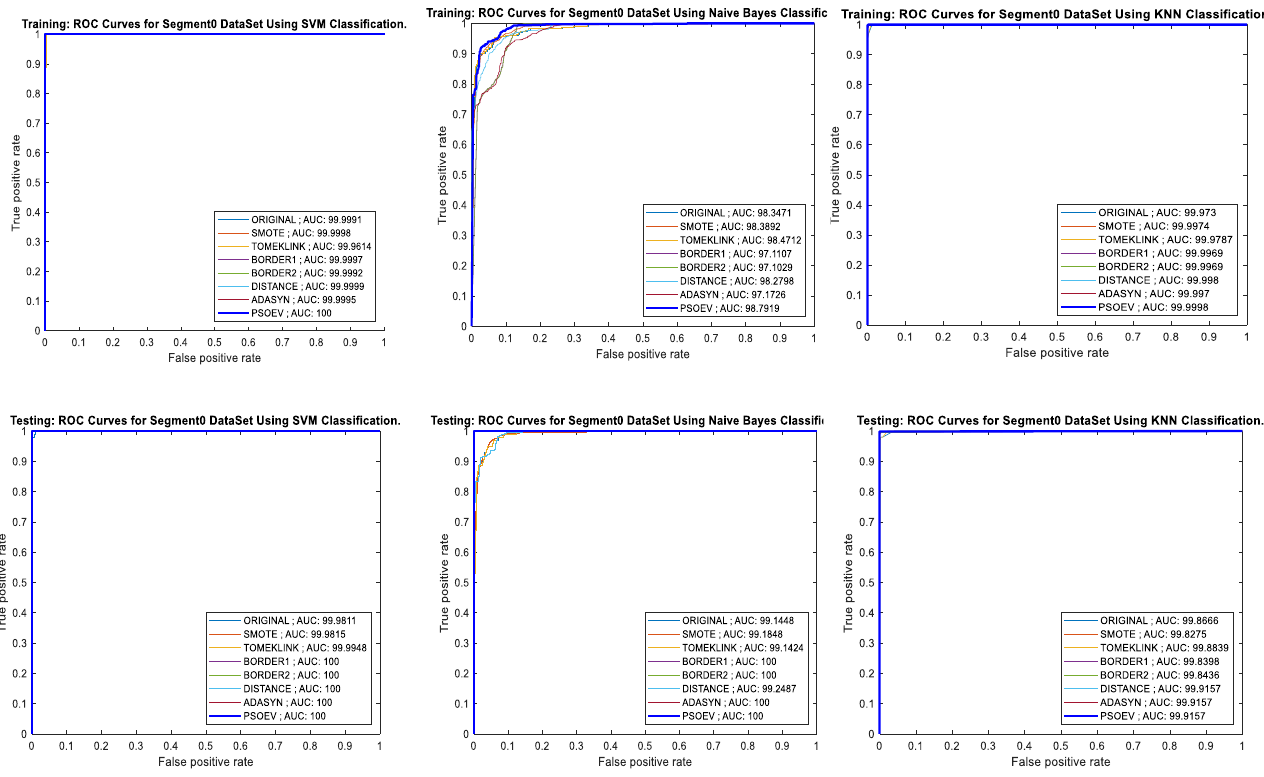
Figure 11. AUC-ROC curves of training and testing of Segment0 dataset using SVM, NB, and k -NN classification methods, respectively.